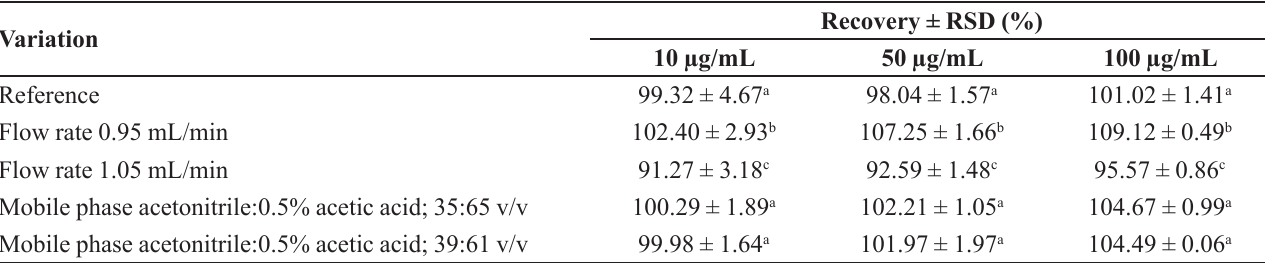
TABLE IV - Robustness results at different levels of flow rate and mobile phase proportion (n=3)